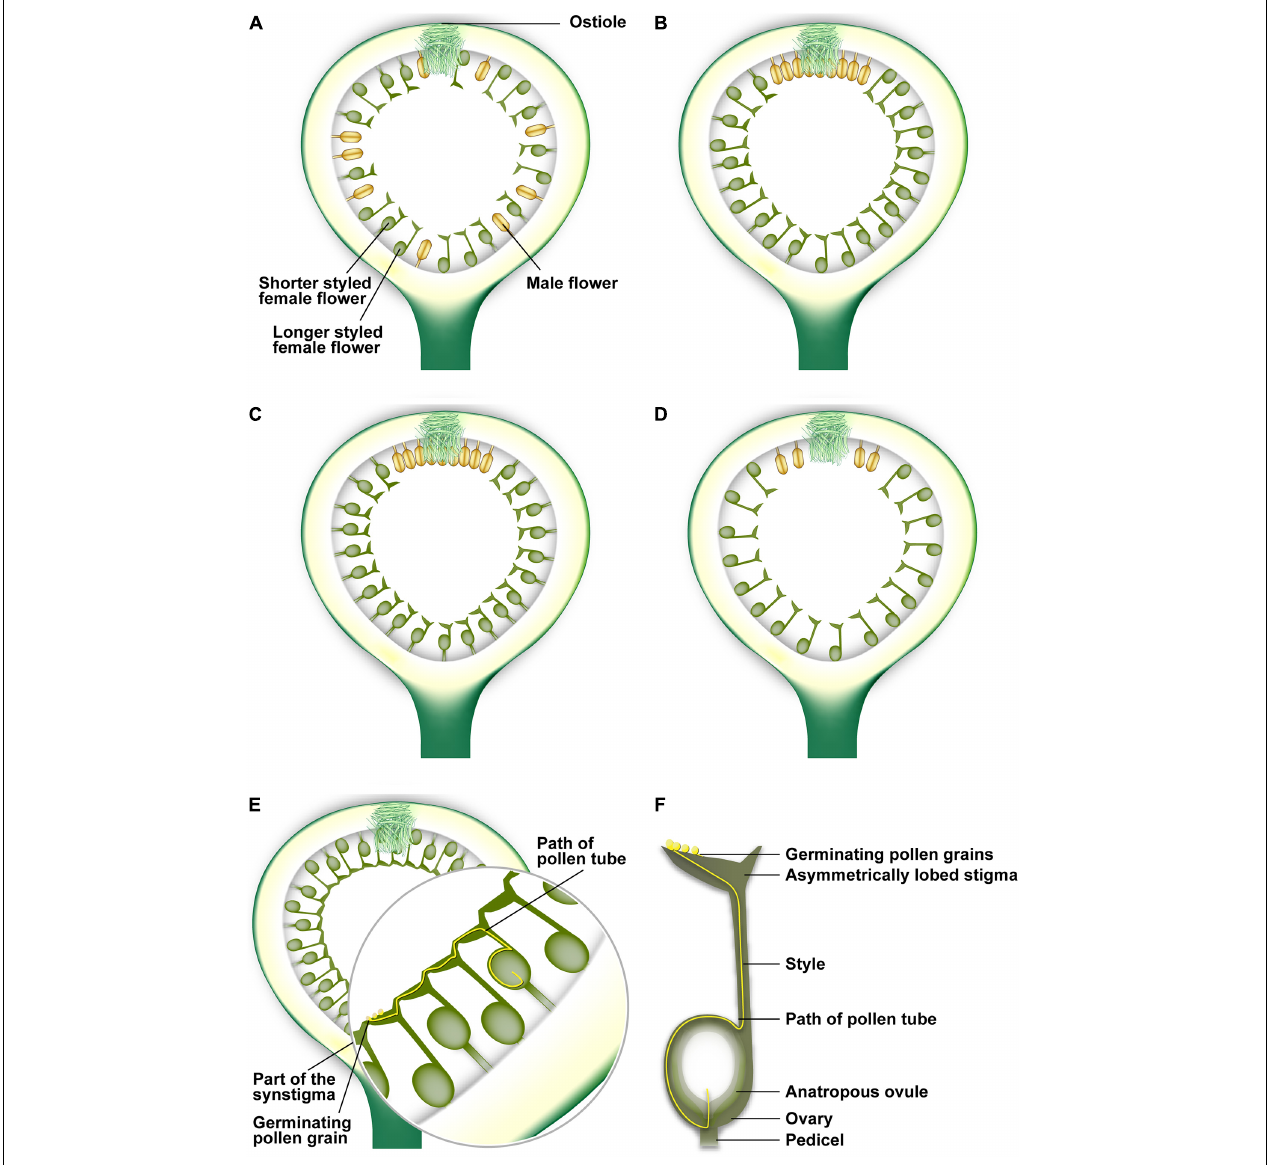
FIGURE 2 | Arrangement of flowers within fig syconia. (A) Passively pollinated syconia usually have male flowers interspersed with female flowers throughout the syconium. (B) Actively pollinated syconia usually have few male flowers near the ostiolar opening. (C) Distribution of short-styled female flowers and a few male flowers in a syconium on a male tree in a gynodioecious fig species. (D) Distribution of long-styled female flowers in a syconium on a female tree in a gynodioecious fig species. (E) The synstigma in the syconium of an actively pollinated fig species showing longer-styled flowers with short pedicels and shorter-styled flowers with long pedicles. The potential path of a pollen tube taken in a synstigma is also shown. (F) The potential path taken by a pollen tube after germinating on an asymmetrically lobed stigma and traversing down the style to enter the micropyle of an anatropous ovule. Illustration by Priya